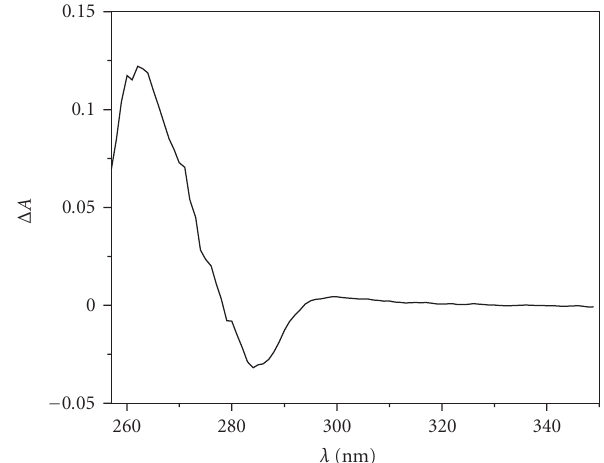
Figure 3: The di ff erential UV spectrum for the Cu(II)-SFG system obtained by subtraction of the spectrum at pH 3.45 from the spec- trum at pH 4.57.